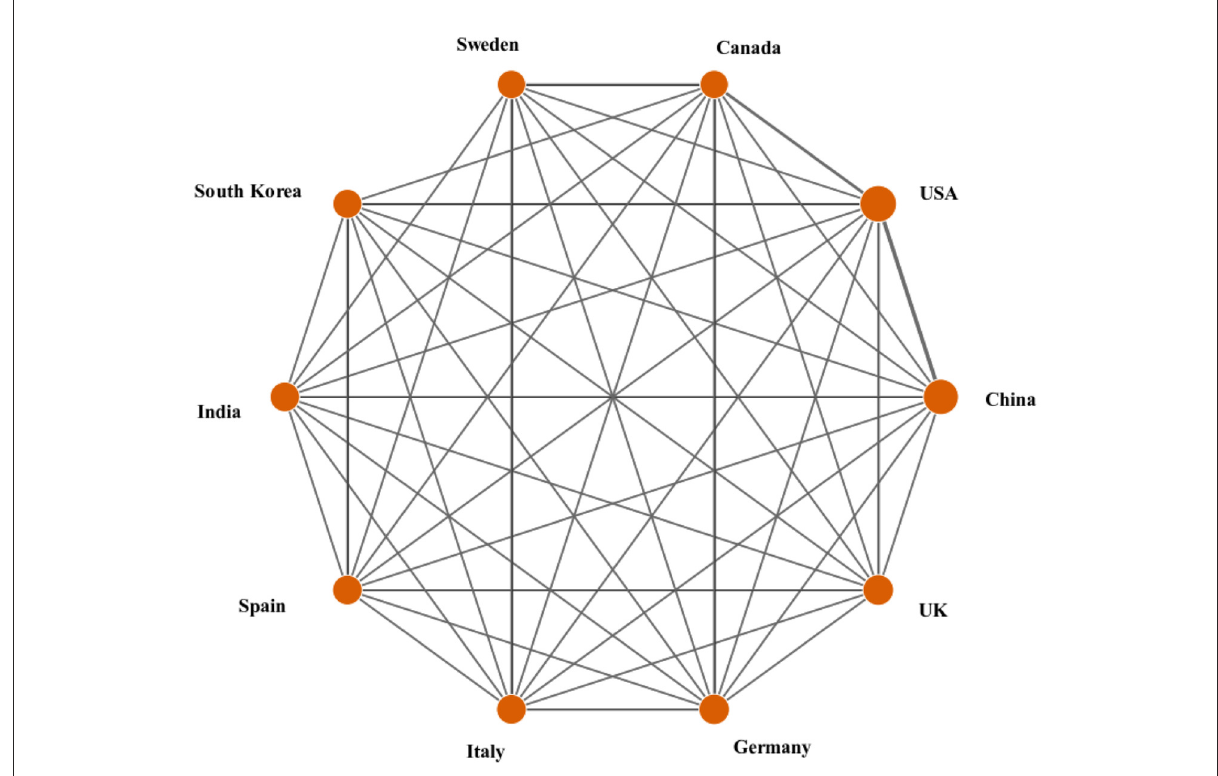
FIGURE3 Collaboration matrix map among the top 10 productive